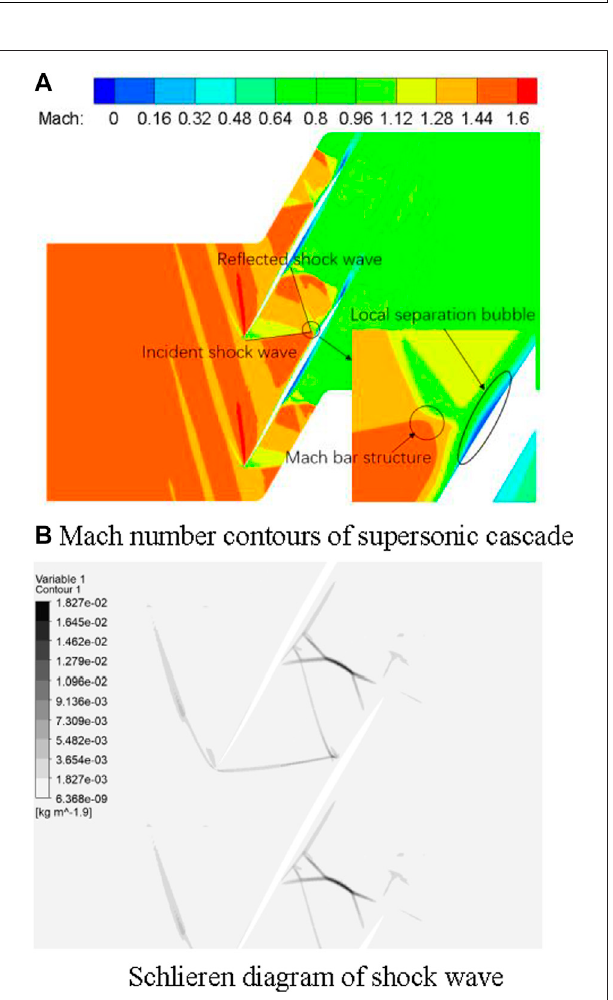
FIGURE 3 | Effect of different turbulence models on isentropic Mach number on the blade